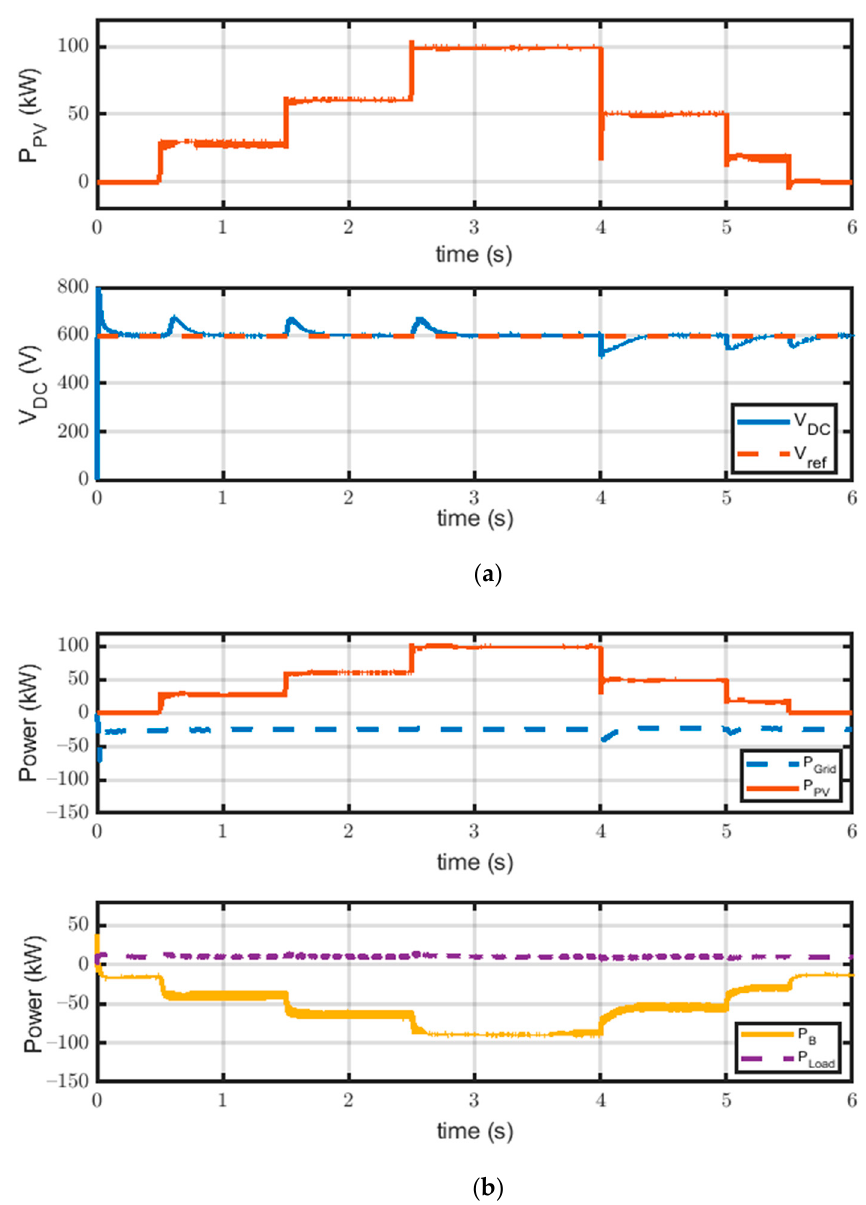
Figure 10. Response of grid-tied PV microgrid with constant grid power; ( a ) PV power and DC voltage at load point, and ( b ) Power Transfer through microgrid.